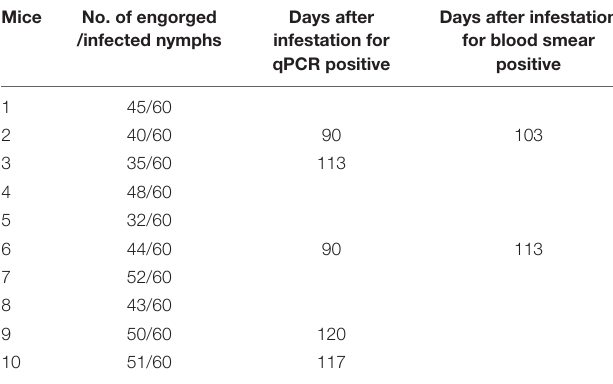
TABLE 5 | Transmission of B. microti to mice by infected H. longicornis nymphs. Mice No. of engorged /infected